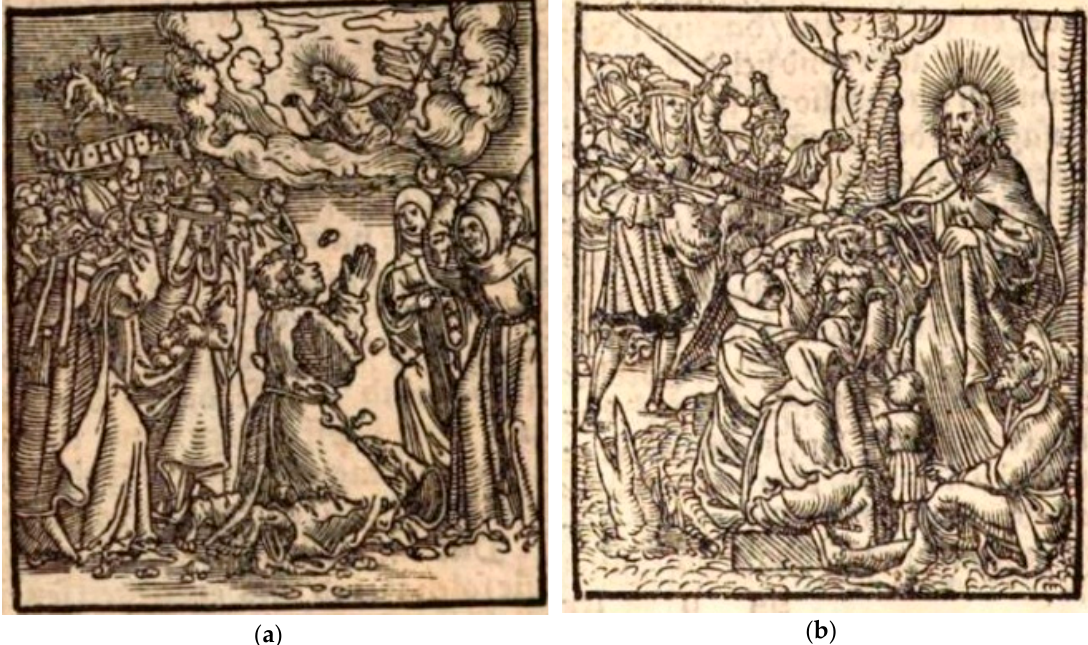
( a ) ( b ) Figure 7. Woodcuts recurring in books published by vom Berg and Figure 7. Woodcuts recurring in books published by vom Berg and Neuber. ( a ) Stoning of St Stephen [S 58], in (Luther 1544b, part 3, fol. XIIv) (Munich, Bayerische Staatsbibliothek, 2 Hom. 277, urn:nbn:de:bvb:12-bsb10144039-2; NoC-NC/1.0) ( b ) Christ preaching and Catholic hierarchs [S 61], in